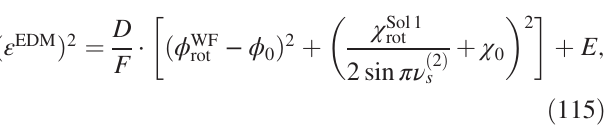
Þ . ; χ Sol 1 rot rot